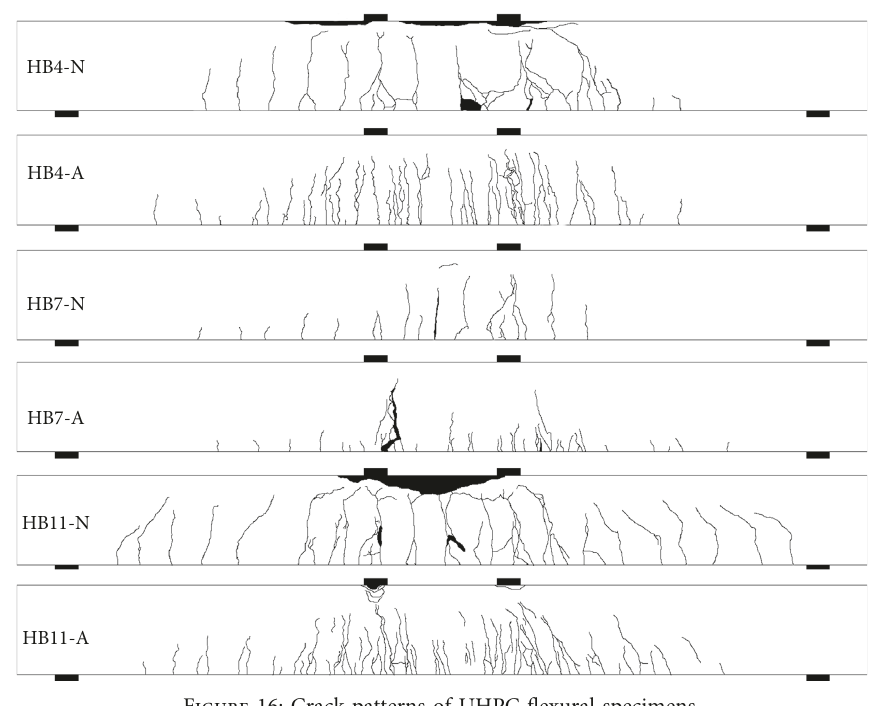
Figure 16: Crack patterns of UHPC flexural specimens.